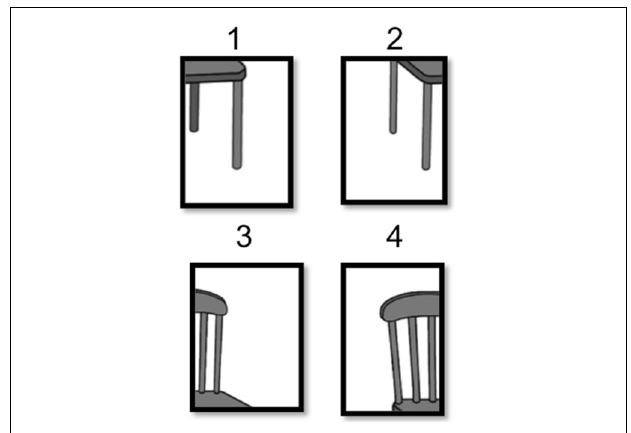
FIGURE 1 | An example of stimuli in the jigsaw puzzle task.